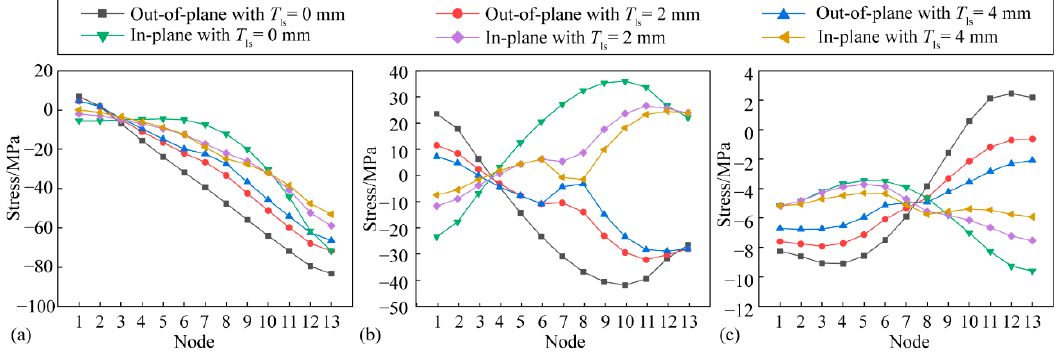
Figure 11. ( a ) Axial, ( b ) tangential, and ( c ) shear stresses in the top flange of the curved zone under 1 P loading.